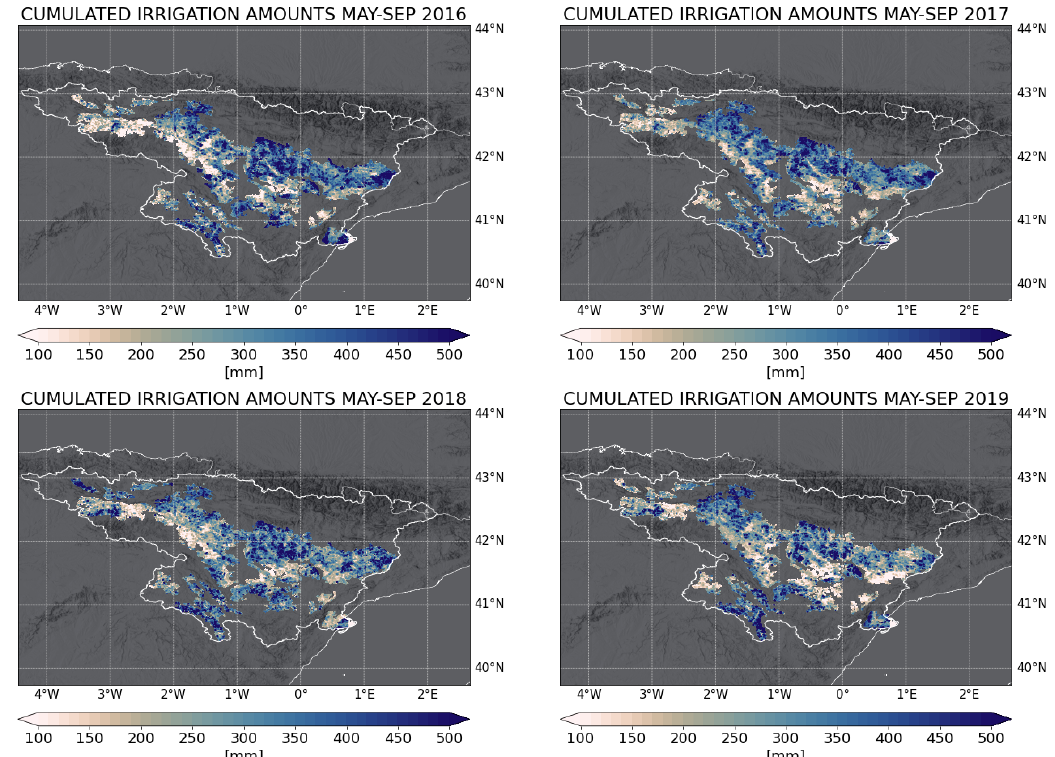
Figure 4. Cumulated irrigation amounts over the Ebro basin (Spain) during the highest-intensity irrigation season (May–September) of 2016, 2017, 2018, and